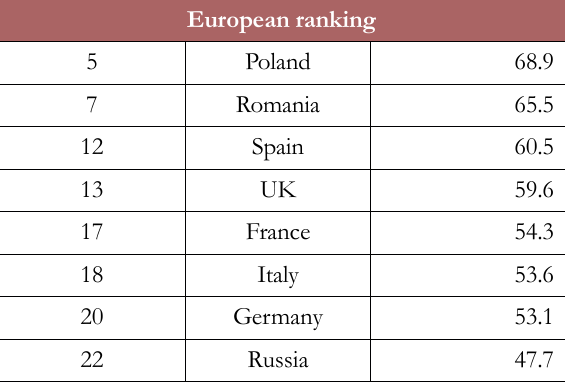
Table 14. Europe utility score compare